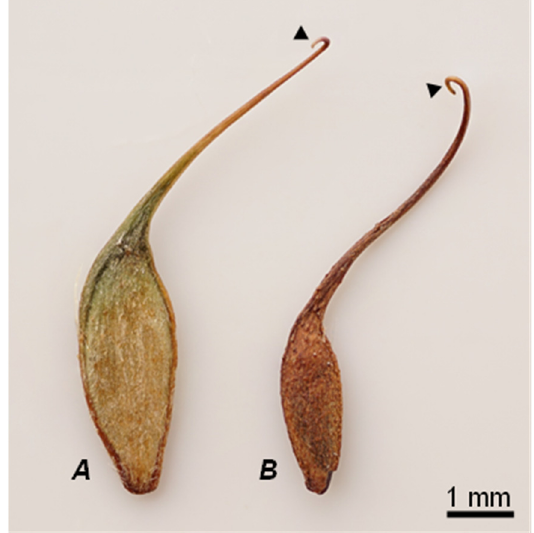
Figure 1. Seeds of Geum urbanum L. ( A ) and Geum rivale L. ( B ) with their typical morphologic adaptations (spikes, hooks, or barbed projections ( )). The scale bar shown corresponds to 1 mm. The fatty-acid composition of the two species revealed the presence of palmitic acid, linoleic acid, α -linolenic acid, and stearic acid as major components, which were assigned on the basis of their mass spectra and a comparison with those of reference compounds and with the NIST database. The relative proportions of individual fatty acids (Figure 2) of the two species were almost identical for palmitic acid ( G. urbanum : 5%; G. rivale : 4%) and stearic acid ( G. urbanum : 3%; G. rivale : 4%). In contrast, the proportions of linoleic acid ( G. urbanum : 15%; G. rivale : 32%), α -linolenic acid ( G. urbanum : 75%; G. rivale : 60%), and eicosanoic acid ( G. urbanum : 2%; G. rivale : 0%) varied